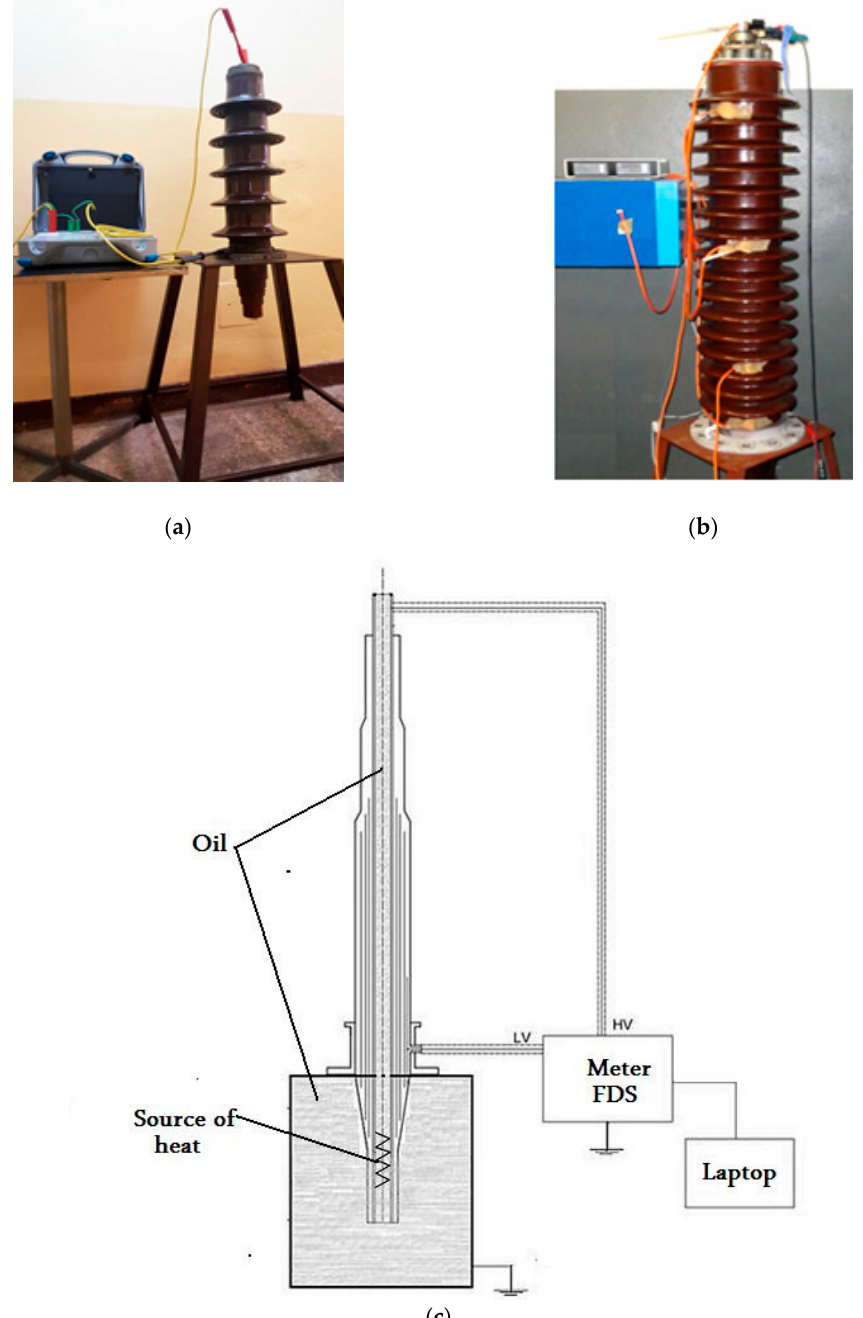
Figure 4. The experimental setup for: ( a ) CRPT bushing; ( b ) CTKF bushing, ( c ) diagnostic scheme of the Frequency Dielectric Spectroscopy (FDS) method.